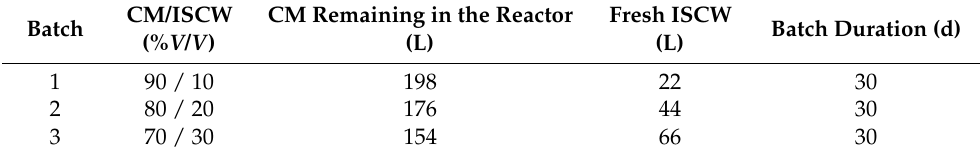
Table 2. Anaerobic digestion of